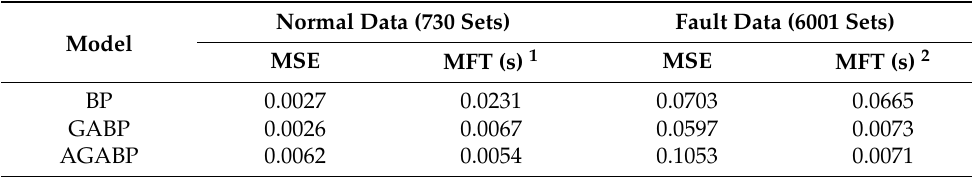
Table 1. The MSE and MFT of each model in normal data and fault